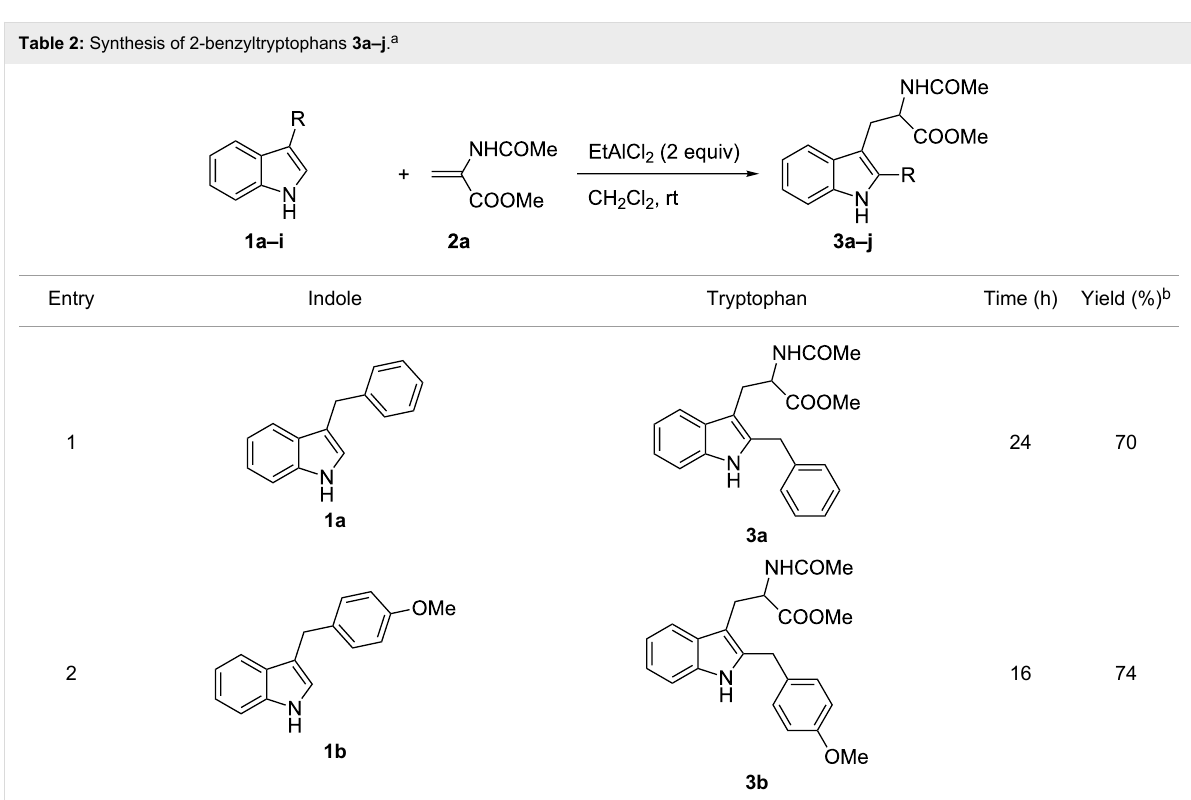
Table 2: Synthesis of 2-benzyltryptophans 3a–j .